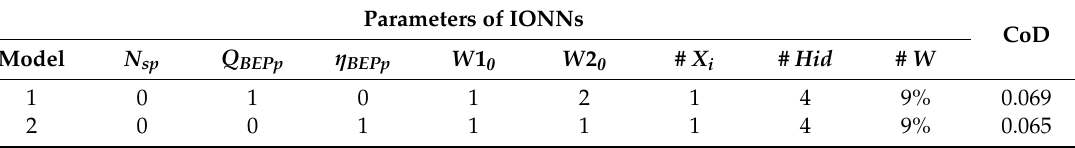
Table 7. Pareto front of IONNs for h for a hyperbolic tangent transfer